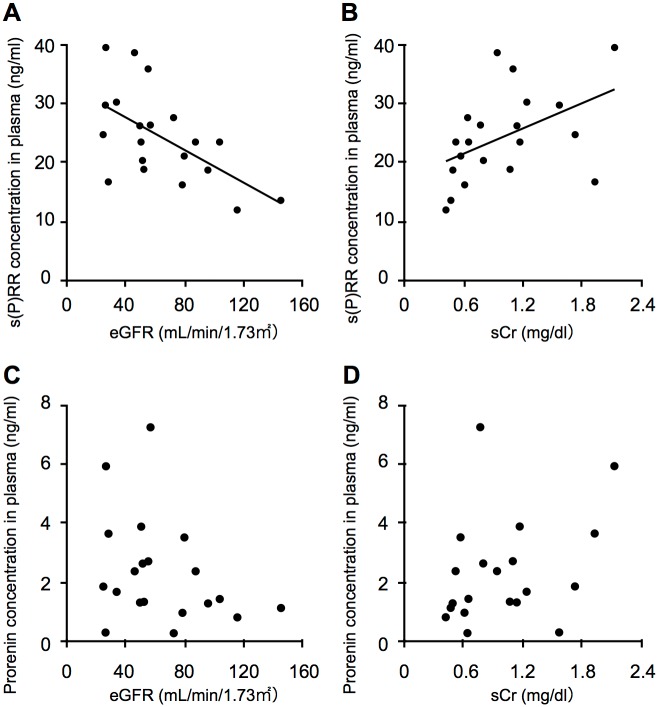
Correlations between plasma s(P)RR and renal dysfunction parameters.Correlations between s(P)RR and renal dysfunction parameters eGFR (A) and sCr (B) in the plasma of patients with PDR. (n = 20, Spearman rank correlation). Correlations between prorenin and renal dysfunction parameters eGFR (C) and sCr (D) were not detected in the plasma of patients with PDR (n = 20, Spearman rank correlation).